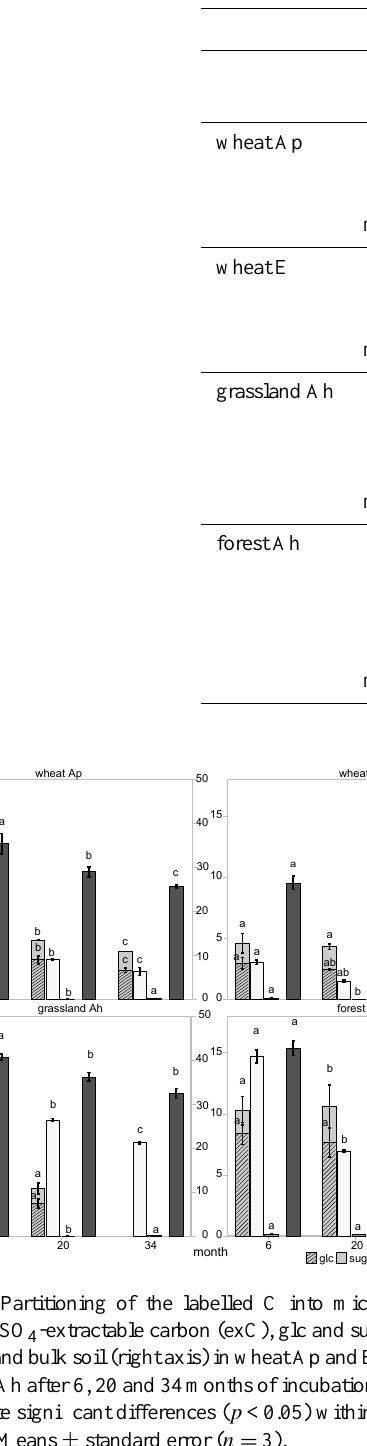
Table 3. Estimated apparent MRT and pool size of sugars in the wheat Ap, wheat E, grassland Ah and forest Ah incubations. ∗ reflects initial exponential growing pools.